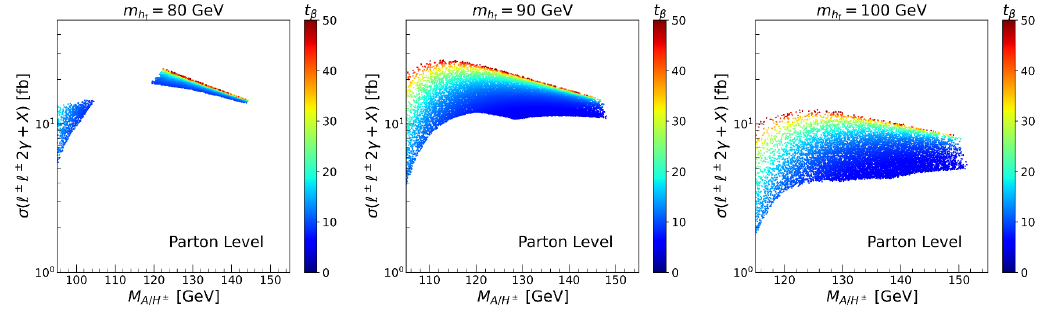
Figure 10 . σ ( pp → ‘ ± ‘ ± γγ + X ) at the 14 TeV LHC about M with the color code of t β . A/H ± The results of m h = 80 GeV , m h = 90 GeV , and m h = 100 GeV , are in the left, middle, and right f f f panels, respectively. The parameter points satisfy Step A, Step B, the CDF 4 γX constraint, and Λ cut > 10 18 GeV